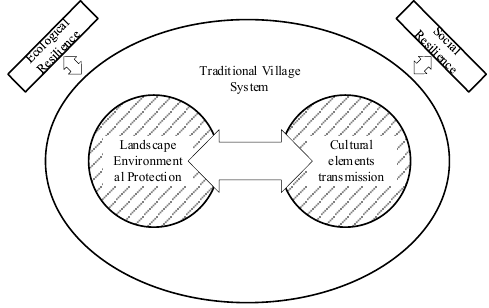
Figure 10. J&W mode diagram.